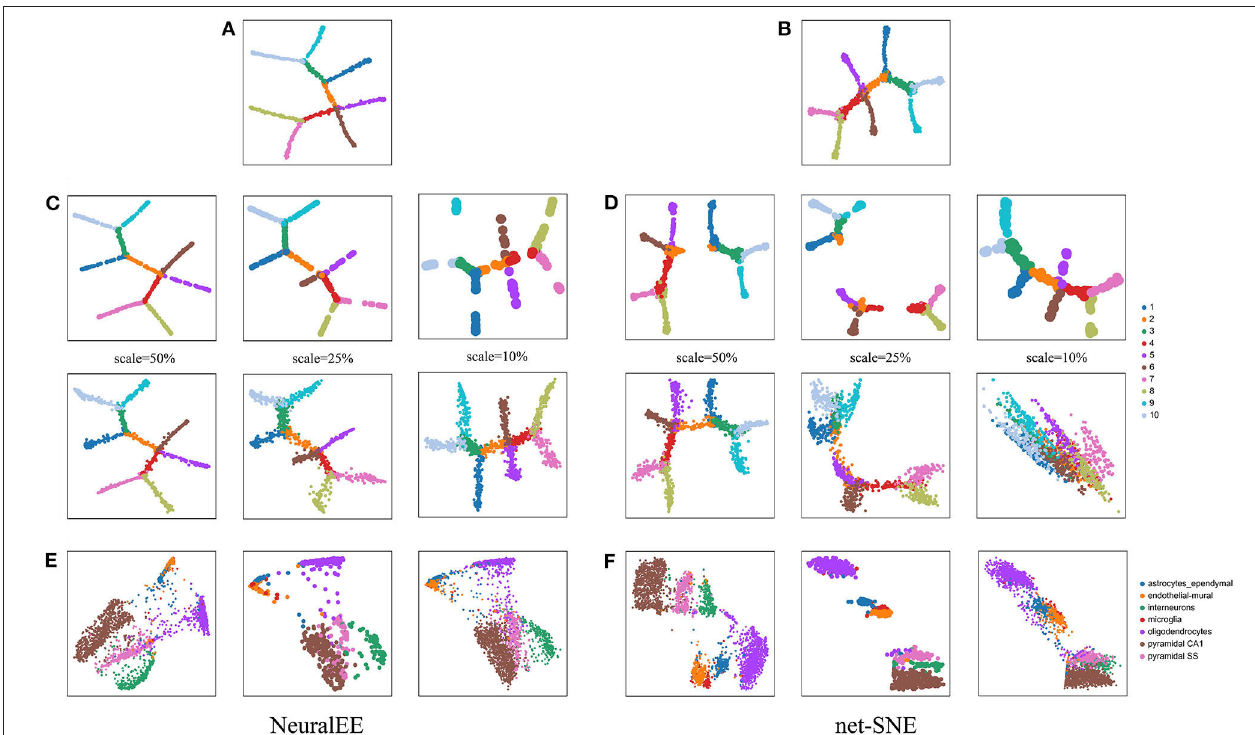
FIGURE 3 | (A) NeuralEE or (B) net-SNE on the full ArtificialTree data. Their embeddings with stochastic optimization are showed at Supplementary Figure 6 . (C) The top line panel is the NeuralEE based on the sub-samples with a sub-sampling scale as the index scale , and the bottom line panel is the mapping of all samples to the embedded space based on the NN trained on the top panel. (D) net-SNE under the similar experiments as (C) . (E) From left to right is the NeuralEE on the entire CORTEX data, NeuralEE based on the sub-samples with a sub-sampling scale of 25%, and the mapping of all samples to the embedded space based on the NN trained on sub-samples. (F) net-SNE under the similar experiments as (E) .